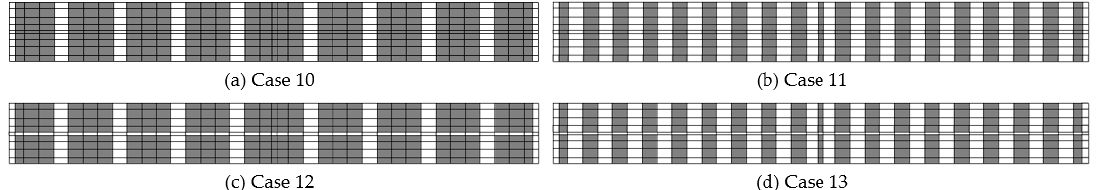
Figure 23. Four fracture profiles with different proppant distributions (gray: propped; white: unpropped).